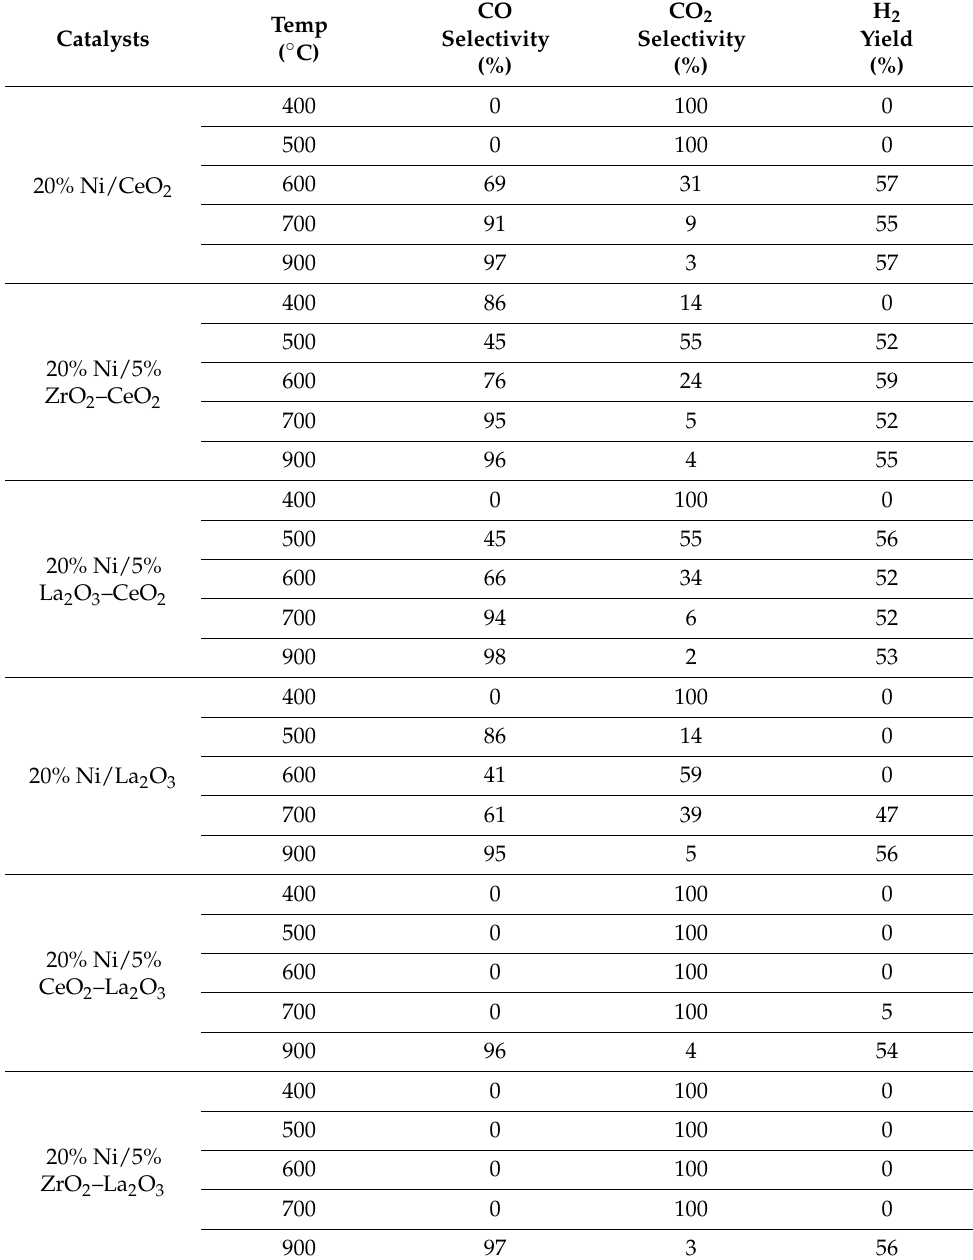
Table 6. The hydrogen yield and selectivity values to CO and CO 2 obtained in the oxy-steam reforming of LNG using supported nickel